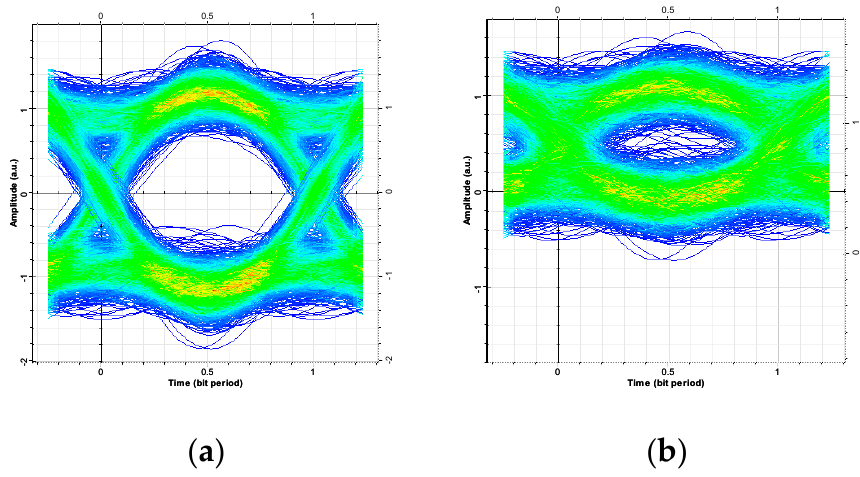
Figure 8. Eye diagrams of payload signals in ( a ) TCK and; ( b ) OOK buffers.